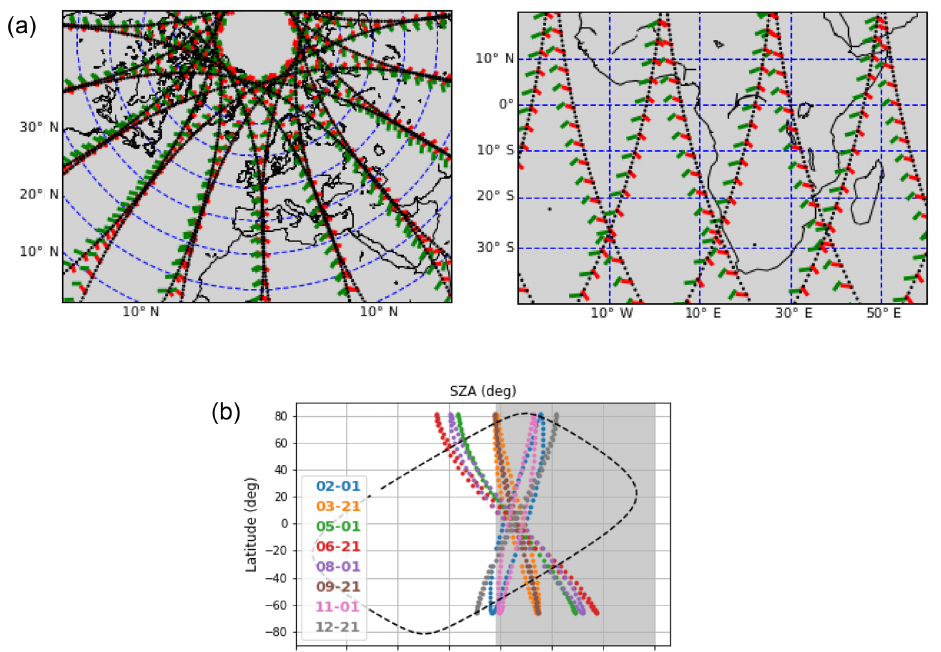
Figure 2. Panel (a) shows the footprints of the forward (45 ◦ ) and aftward (135 ◦ ) views over a 24h period. The forward antenna is used during the upward scans (red lines) and the aftward one during the downward scans (green lines). The first tangent point of the upward scans are located on the black-dotted lines. Panel (b) shows the solar zenith angles with respect to latitudes for various days representative of the seasonal variation (colored dots) together with those of the Aura MLS data (DJF, 2011) used in the simulations (dashed line). The shaded area shows the nighttime measurements in the mesosphere, where the O 3 diurnal variation is the